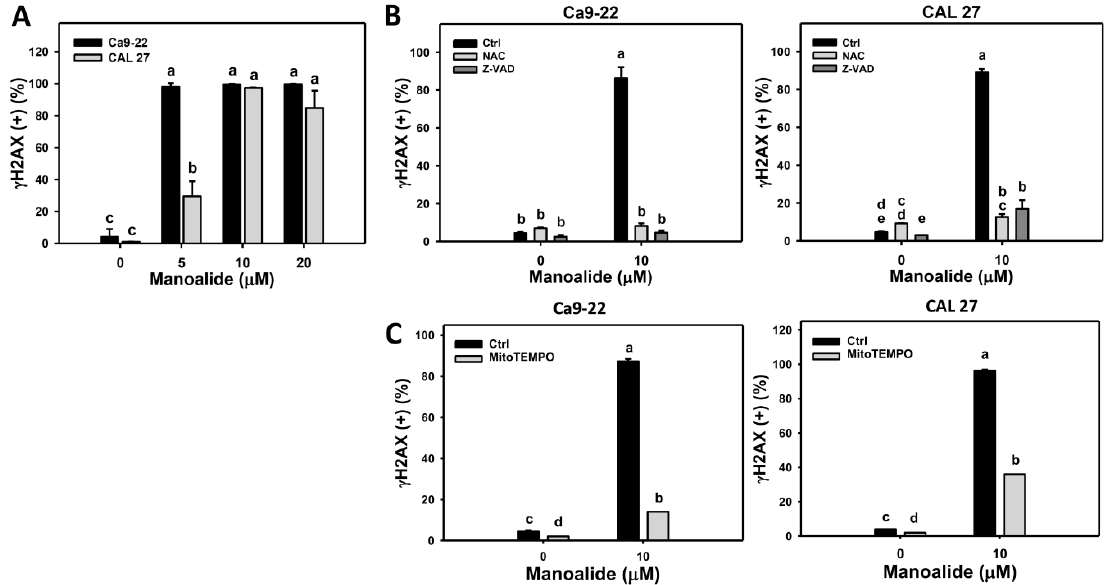
Figure 7. Change of γ H2AX DNA damage in manoalide-treated oral cancer (Ca9-22 and CAL 27) cells. Cells were treated with the indicated concentrations of manoalide for 24 h. ( A ) Statistical results of γ H2AX ( + ) (%) for manoalide-treated oral cancer cells in Figure S10A. ( B ) Statistical results of γ H2AX ( + ) (%) in NAC, Z-VAD, and / or manoalide-treated oral cancer cells in Figure S10B. Cells were pretreated with 8 mM, 1 h for NAC or 100 µ M, 2 h for Z-VAD, and then post-incubated with 10 µ M of manoalide for 24 h. ( C ) Statistical results of γ H2AX ( + ) (%) in MitoSOX inhibitor (MitoTEMPO) and / or manoalide-treated oral cancer cells in Figure S10C. Cells were pretreated with MitoTEMPO (20 µ M, 1 h) and posttreated with manoalide (10 µ M, 24 h). Data were analyzed by one-way ANOVA with Tukey HSD Post Hoc Test. Data, means ± SDs ( n = 3). Data showing no overlapping same small letters represent significant di ff erence ( p < 0.05–0.001).